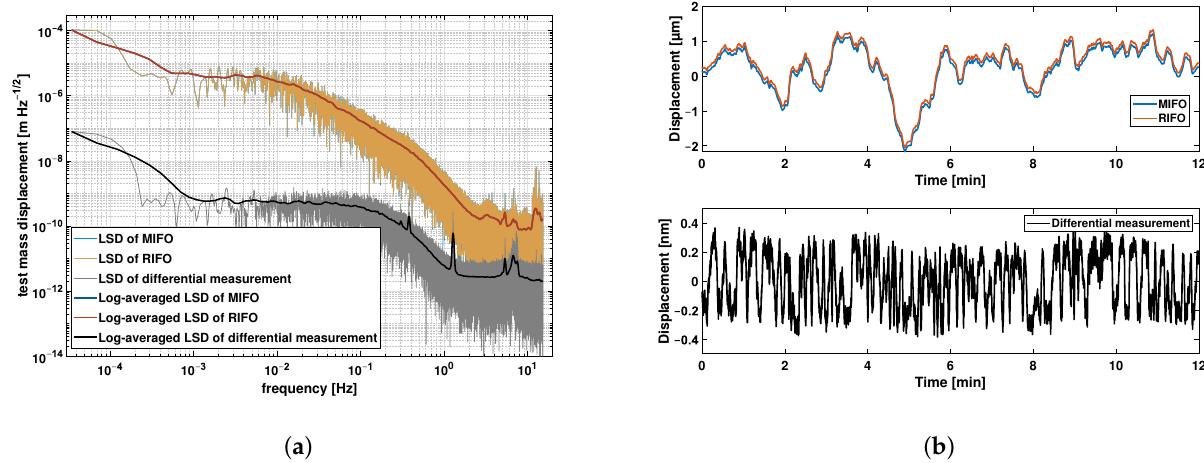
Figure 4. Preliminary test results. ( a ) LSD and its logarithmic average of the MIFO, RIFO, and differential measurements, respectively; ( b ) time series of a 12-min section of the MIFO, RIFO, and differential measurements. The traces of measure- ment results from MIFO and RIFO highly overlap in ( a ). Experimental results show a noise floor of 1.64 × 10 − 7 m/ at 100mHz for individual interferometers, and a noise floor of 2.76 × 10 − 10 m/ surement, which is enhanced by three orders of magnitude from individual interferometers. The drift for differential measurement is 7.56 × 10 − 10 m over a period of 12